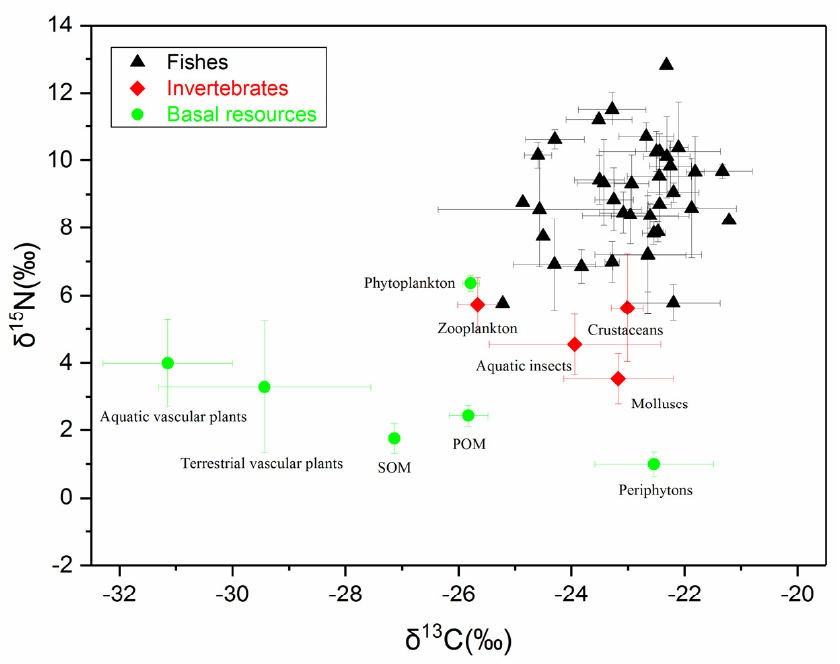
Figure 2. Stable isotope ( δ 13 C and δ 15 N) signatures bi-plot for basal resources (green dots), inverte- brates (red diamonds), and fishes (black triangles) in the midstream of the Chishui River.